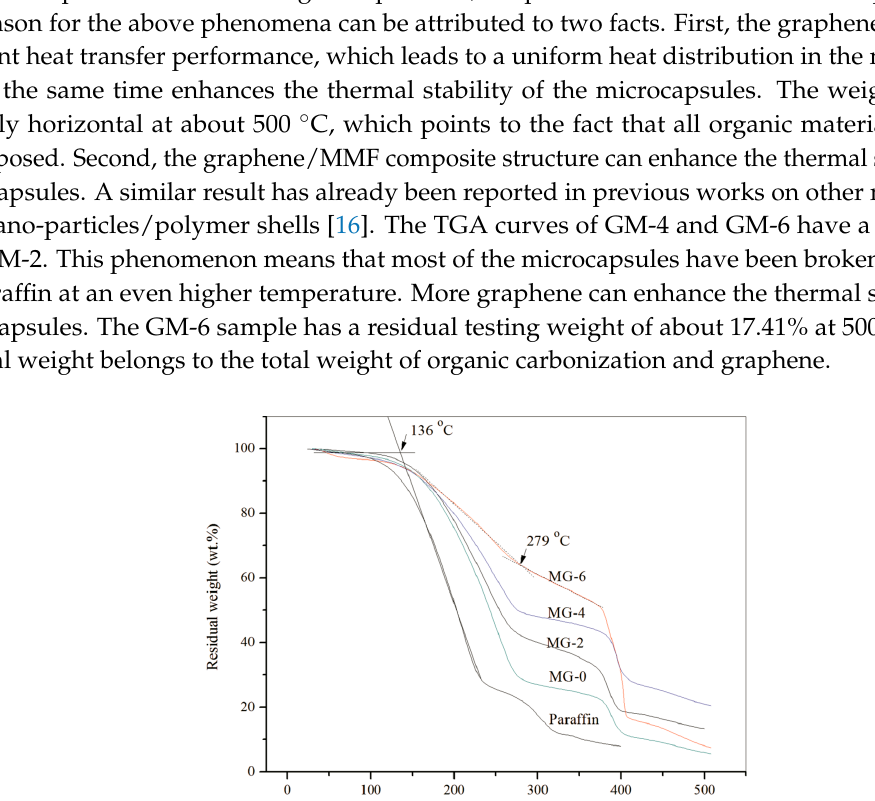
Figure 10. SEM morphologies of microPCMs sample (MG-2) at various temperatures, ( a ) 100 °C; ( b ) 150 °C; ( c ) 200 °C; ( d ) 250 °C; ( e ) 300 °C and ( f ) 350 °C.